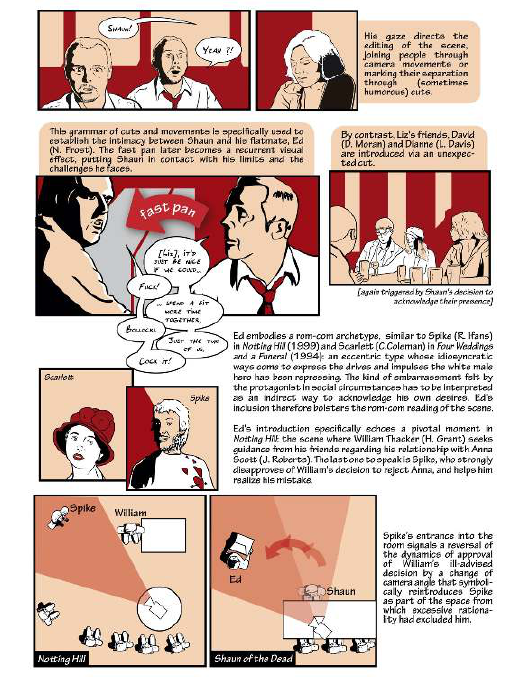
Credits: Jean-François Baillon and Nicolas Labarre.